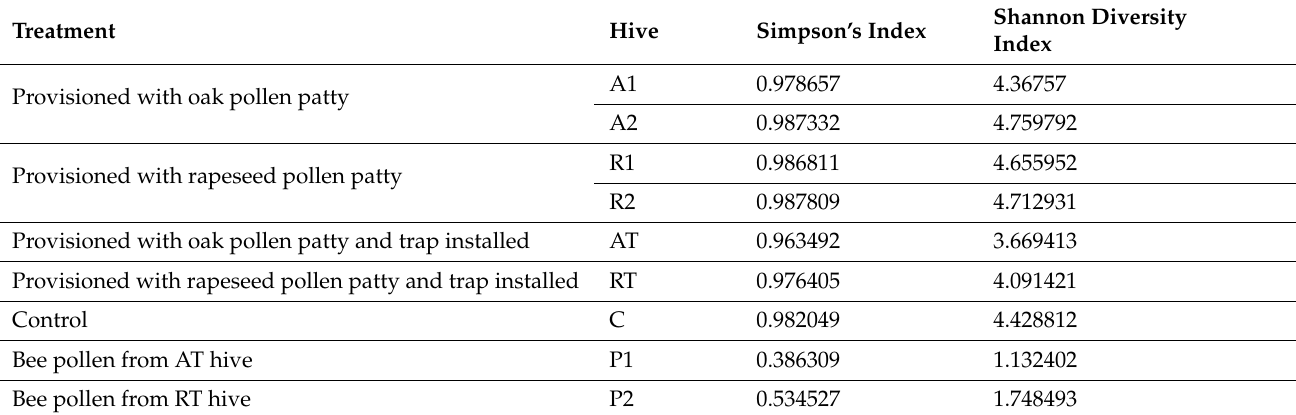
Table 1. Bacterial biodiversity indices of the studied bee bread and bee pollen (A1 and A2 = bee breads collected from two colonies fed with oak pollen patty; R1 and R2 = bee breads collected from two colonies fed with rapeseed pollen patty; AT = bee bread collected from colony fed on oak pollen patty with restricted inflow of pollen from outside; RT = bee bread collected from colony fed on rapeseed pollen patty with restricted inflow of pollen from outside; P1 and P2 = bee pollen collected from bee hives equipped with pollen trap; C = bee bread collected from control hive).